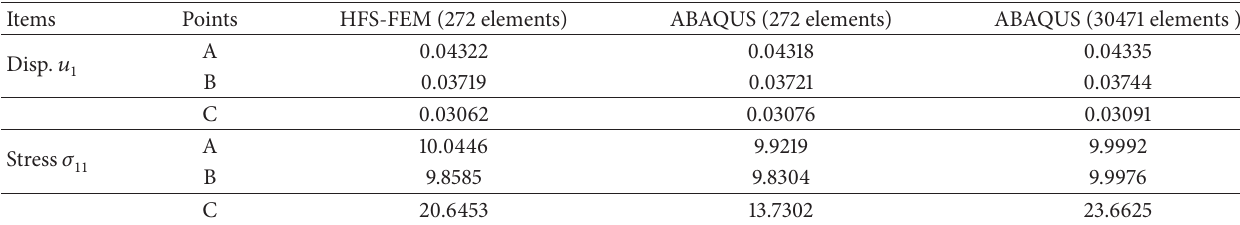
Table 2: Comparison of displacement and stress at points A and